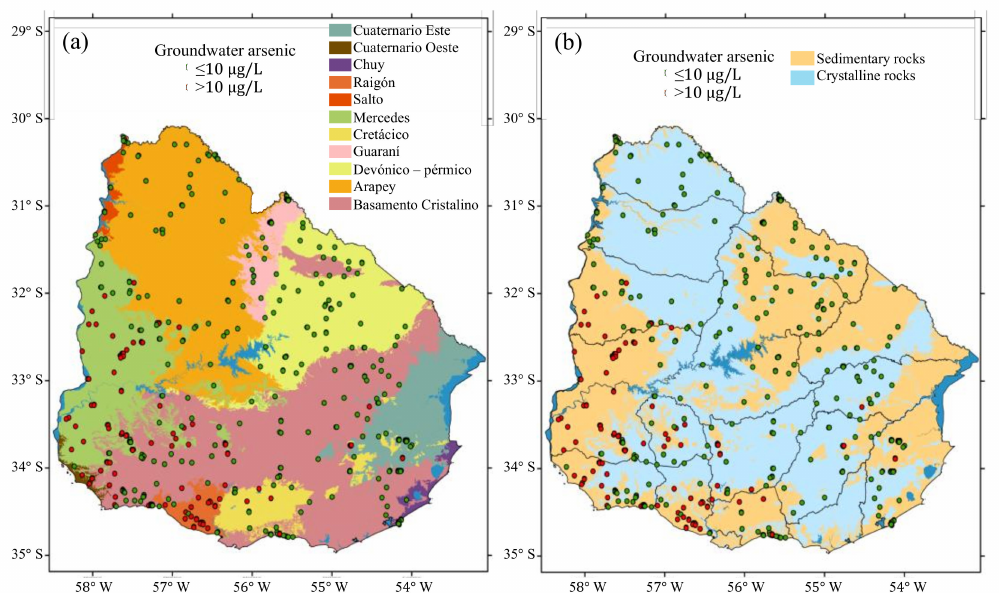
Figure 1. Location of groundwater with arsenic concentration data used in this study and the distribution with respect to ( a ) main aquifers and ( b ) sedimentary and crystalline rocks in Uruguay [34]. Note that the Cret á cico Arapey Formation is composed of basalts, with vacuolar porosity and some interbedded sandstones. Although arguably ambiguous, we classify these here as crystalline. Groundwater arsenic data are from OSE. Aquifer map ( a ) modified from